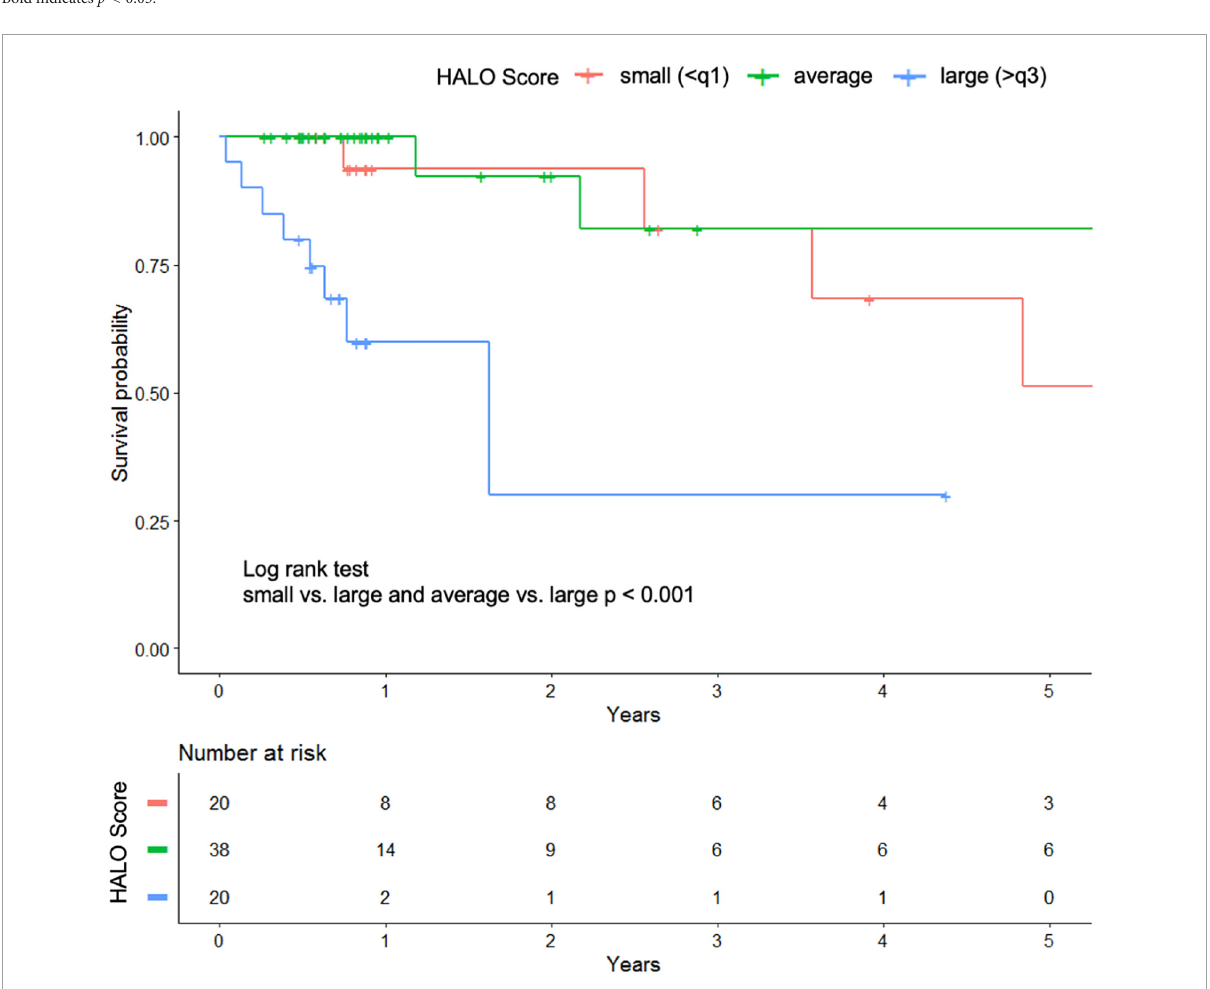
FIGURE4 Kaplan–Meier plot of the validation cohort stratified by quartiles of the HALO